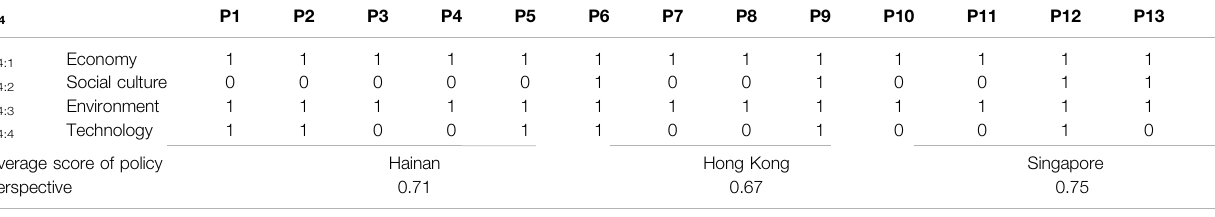
TABLE 9 | Relative lack of policies in the socio-cultural fi eld of Hainan Tropical Rainforest National Park.